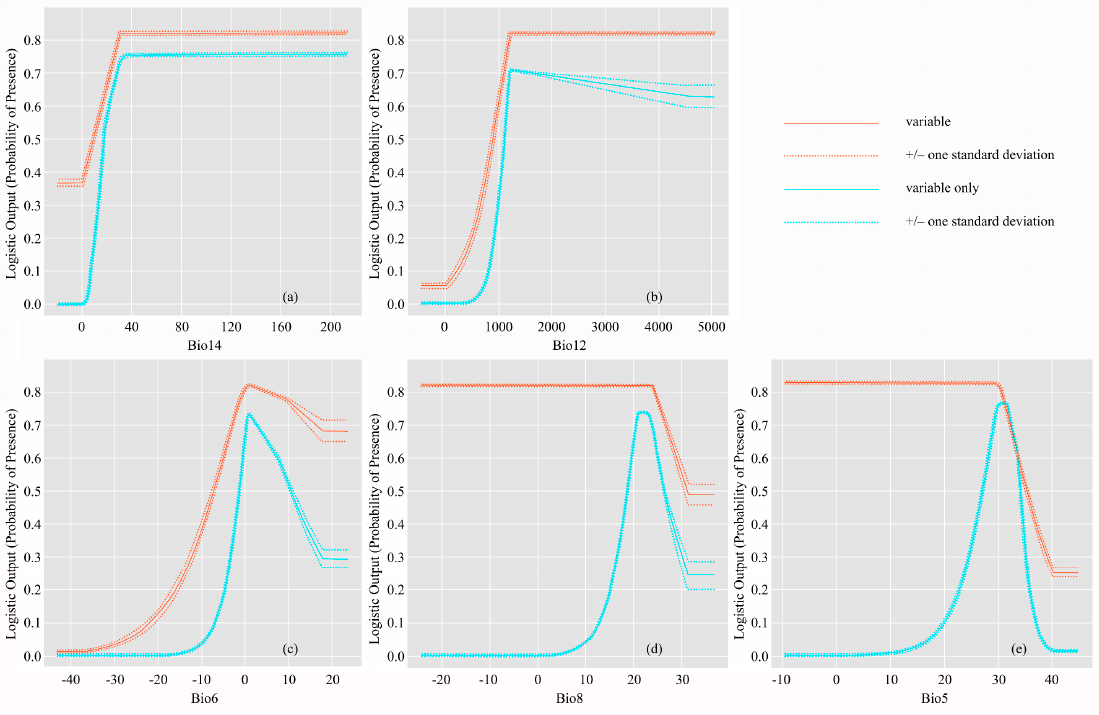
Figure 4. Response curves characterizing how each variable affected the Maxent predictions. Red lines show how the logistic prediction changed as each climate variable was varied while keeping all other variables at their average sample value. Blue lines illustrate Maxent models created using only the corresponding variable. Solid lines represent the mean response of 10 replicate Maxent runs while dashed lines represent the mean ± one standard deviation.